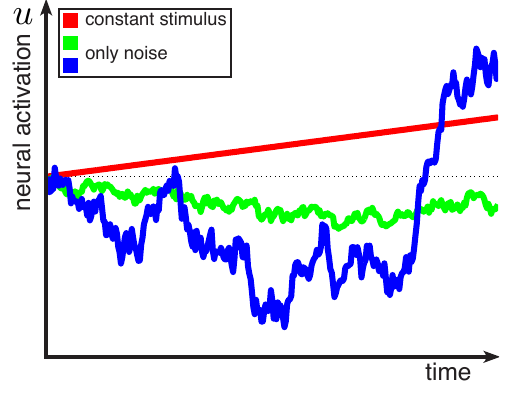
Figure 4: Example trajectories for neural activation variables with two different categories of change rate. The system with a constant rate of change from Equation 5 grows in a straight line (red). The system with only random fluctuations from Equation 6 grows in the pattern of a random walk (green and blue for two different noise parameter